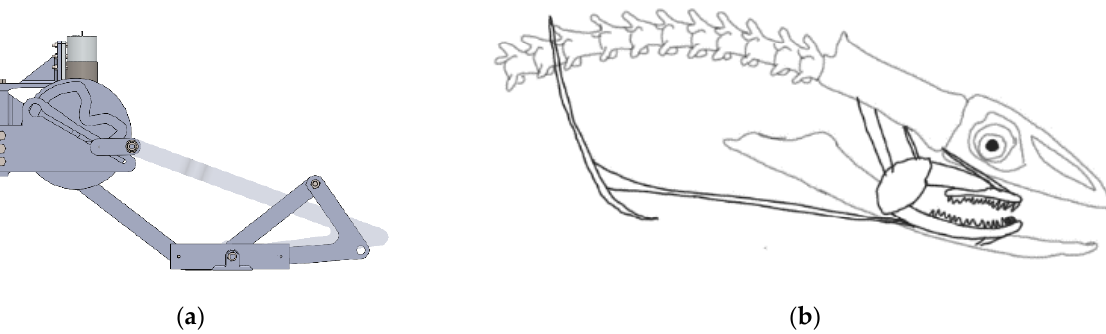
Figure 19. The pharyngeal jaw at biting instant: ( a ) as the mechanism; ( b ) as the moray illustration.